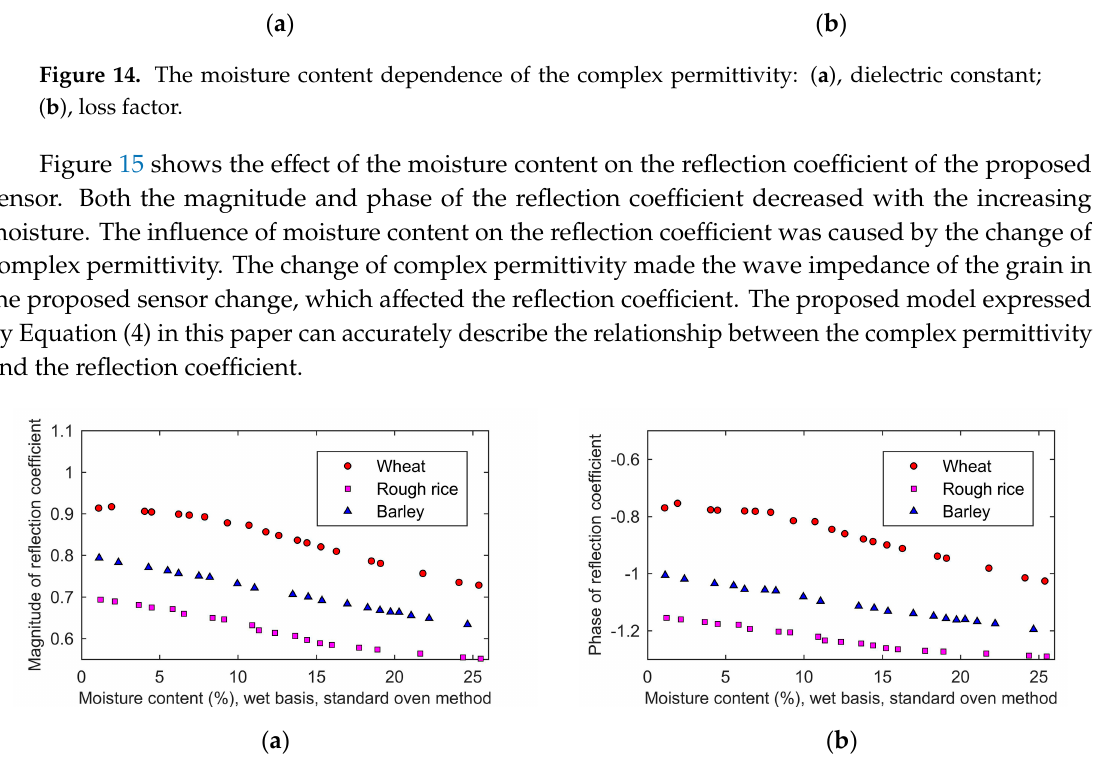
Figure 15. The moisture content dependence of the reflection coefficient: ( a ), magnitude; ( b ), phase.